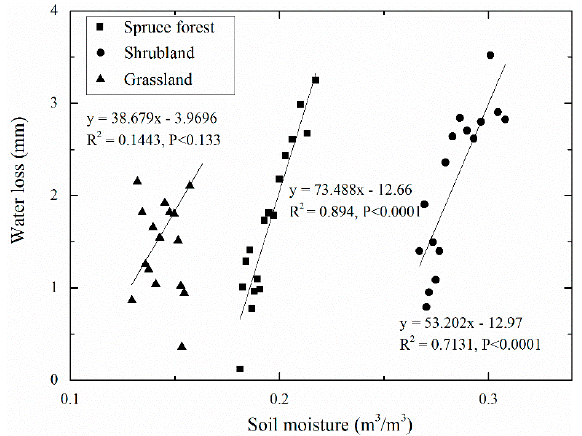
Figure 7. The regression relationship between water loss and daily average soil moisture at the surface soil (0–40 cm) under three vegetation types.